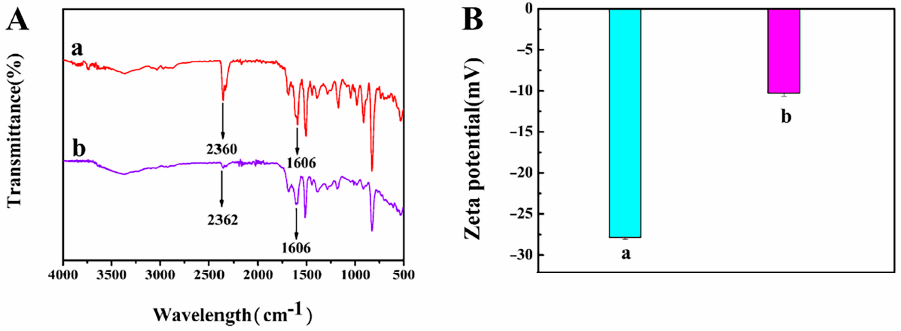
Figure 4. ( A ) FTIR spectra of COFs nanomaterials (a) and AuNPs@COFs nanocomposites (b); ( B ) zeta plots of COFs nanomaterials (a) and AuNPs@COFs nanocomposites (b).